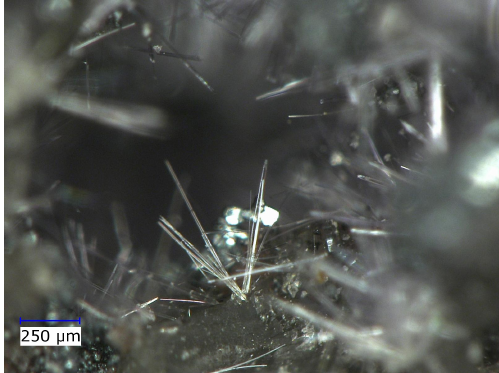
Figure 1. Mullite-2 c crystals grown on a xenolith from Ettringer Bellerberg, Eifel area,